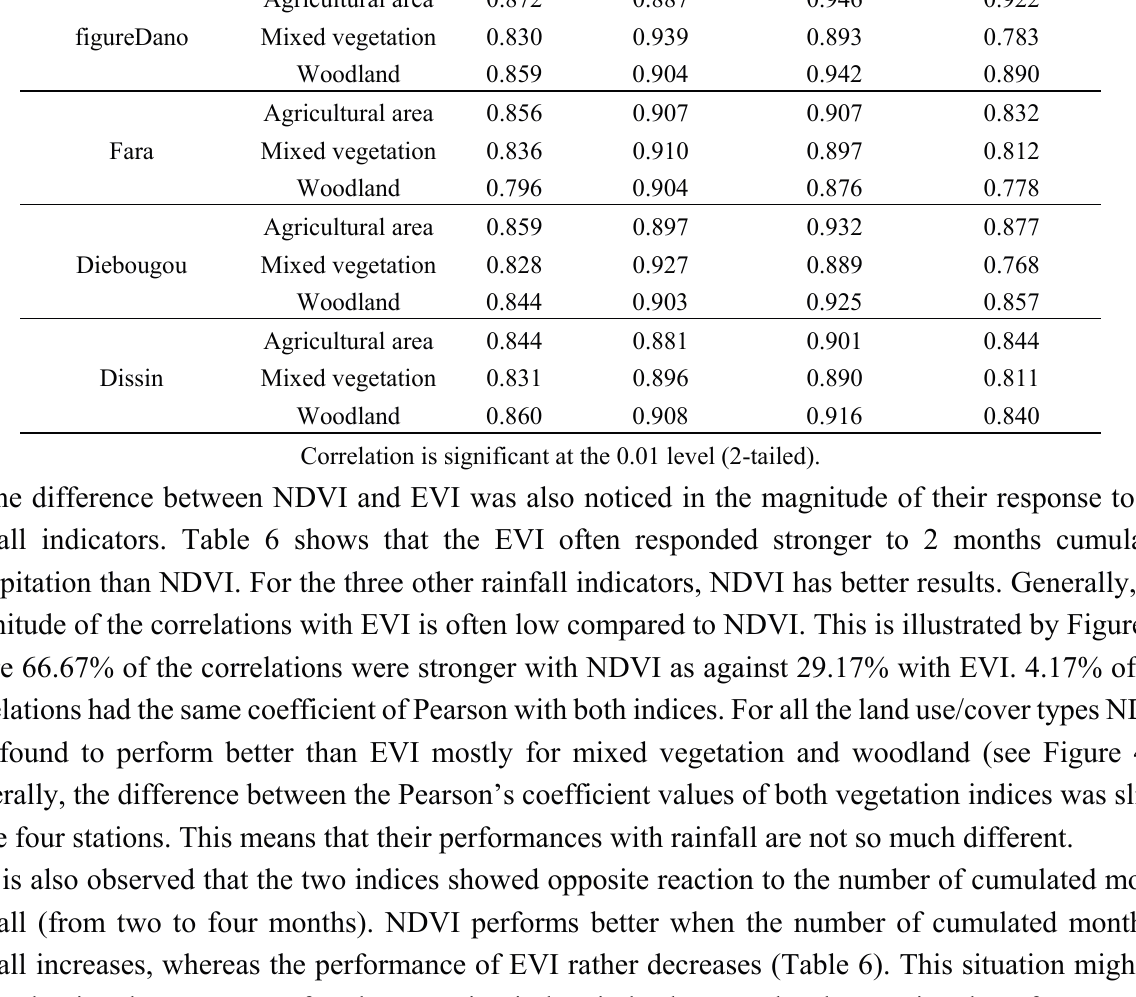
1 Month Cum. 2 Cum. 3 Cum. Lag pcp Months pcp